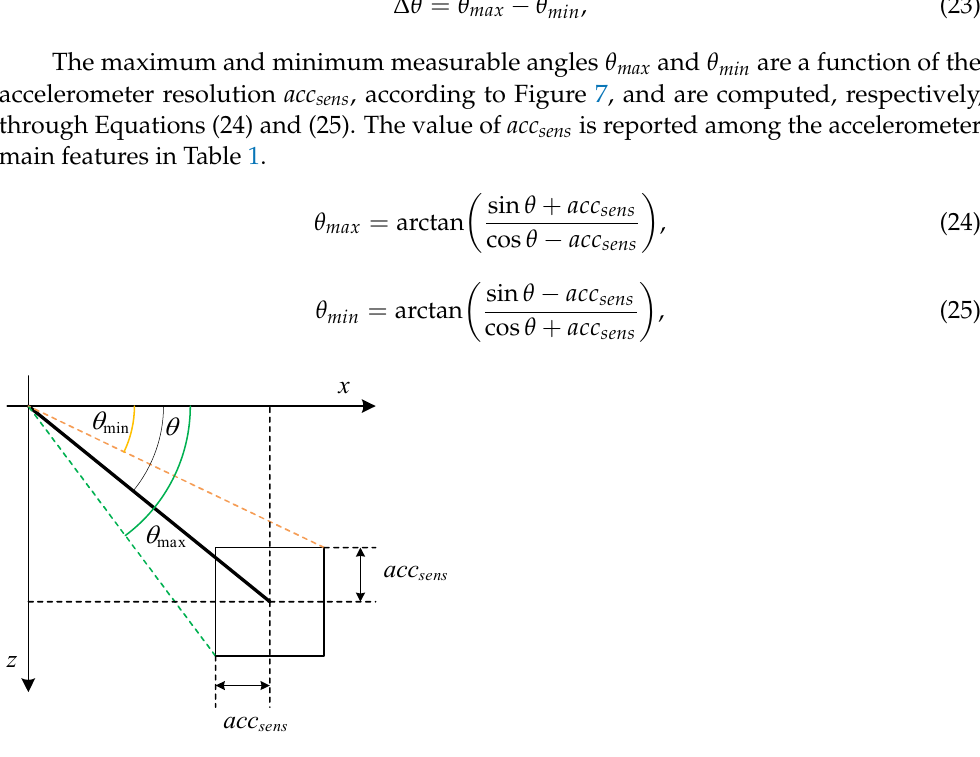
Figure 7. Schematization of angles in the vertical plane for the computation of θ max and θ min , used to obtain the sensor uncertainty. This error may vary depending on the angle's actual value. However, since the angle all the range of interest.